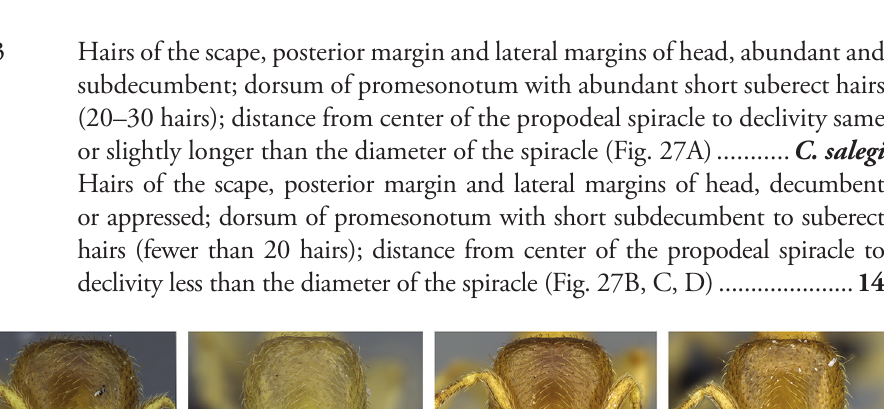
Figure 27. Head in full-face view of A Carebara salegi (CASENT0438115) B Carebara lova (CASENT0468562) C Carebara omasi (CASENT0028947) D Carebara nosindambo (CASENT0073105). 14 Dorsum of propodeum weakly convex; posterodorsal corner with a pair of very short triangular teeth, length less than propodeal spiracle diameter (Fig. 28A) .................................................................................................. C. lova – Dorsum of propodeum convex; posterodorsal corner of propodeum with a pair of triangular and laminate teeth, length same as propodeal spiracle diam- eter ........................................................................................................... 15 15 Anterodorsal corner of petiole convex; side of propodeum areolate-rugose, pro- podeal lobes subtriangular and obtusely rounded; gaster with short decumbent to appressed hairs and long subdecumbent hairs (Fig. 28B) ............... C. omasi – Anterodorsal corner of petiole rounded; median area of side of propodeum smooth and shining, propodeal lobes short and convex; gaster with short decumbent to subdecumbent hairs and long subdecumbent to suberect hairs (Fig. 28C) ............................................................................ C. nosindambo 16 In profile, declivity of propodeum concave to weakly concave (Fig. 28D, F) .... 17 – In profile, declivity of propodeum flat (Fig. 28G) ..................................... 20 17 Gaster with short decumbent to subdecumbent hairs and long subdecumbent to suberect hairs, lateropropodeum almost smooth and shiny (Fig. 28D) .. 18 – Gaster with short appressed to decumbent hairs and long subdecumbent hairs, lateropropodeum sculptured (Fig. 28F) ........................................... 19 18 Gaster with short subdecumbent to decumbent hairs, and more than ten longer subdecumbent or suberect hairs; distance from propodeal spiracle to declivity less than the diameter of the spiracle (Fig. 28H) ................. C. tana – Gaster with abundant subdecumbent hairs, and with fewer than ten longer suberect hairs; distance from propodeal spiracle to declivity same as the diam- eter of the spiracle (Fig. 28E) ......................................................... C.